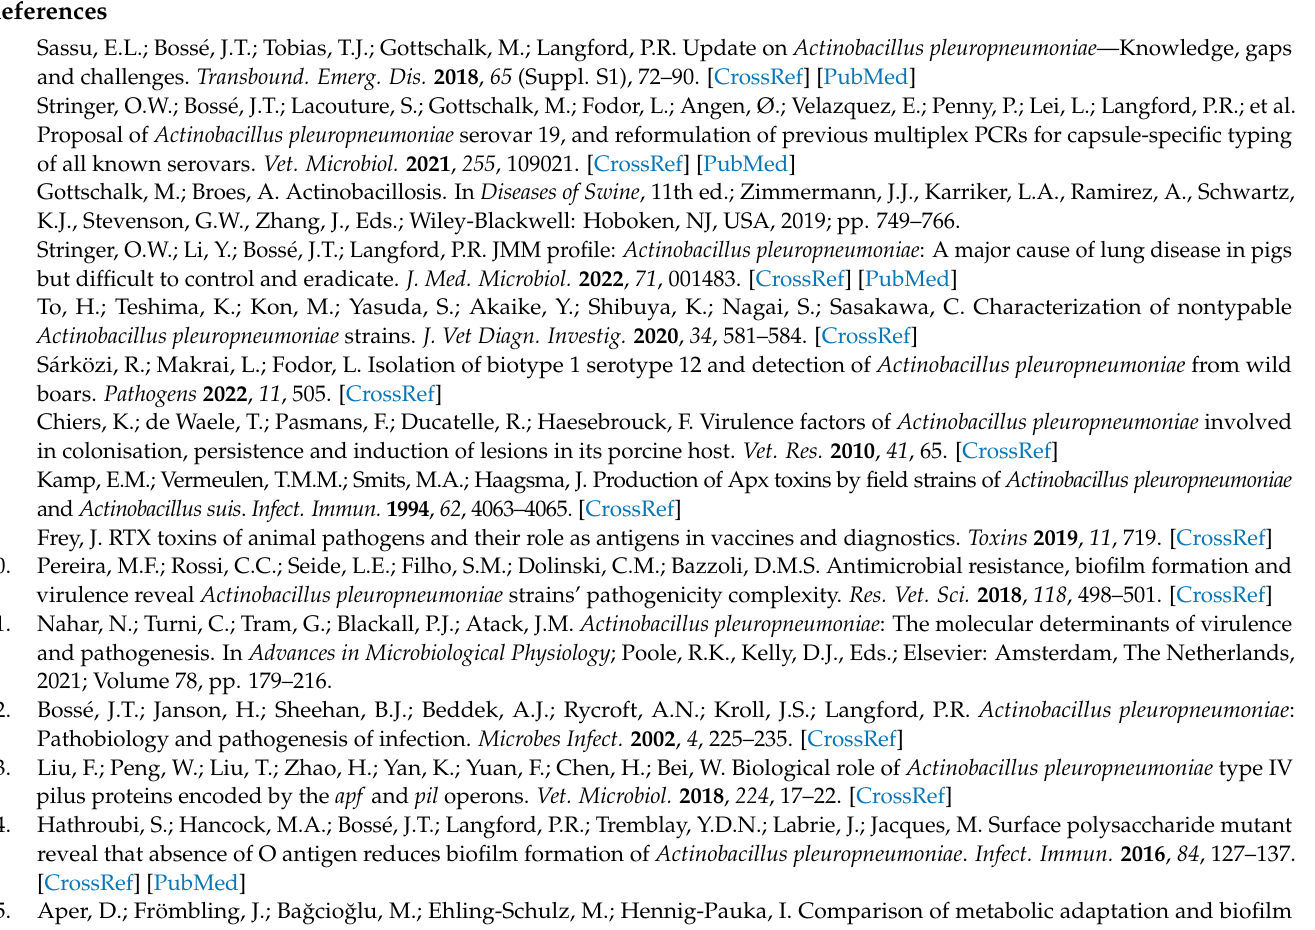
Table S2: Genome contiguity statistics as output by